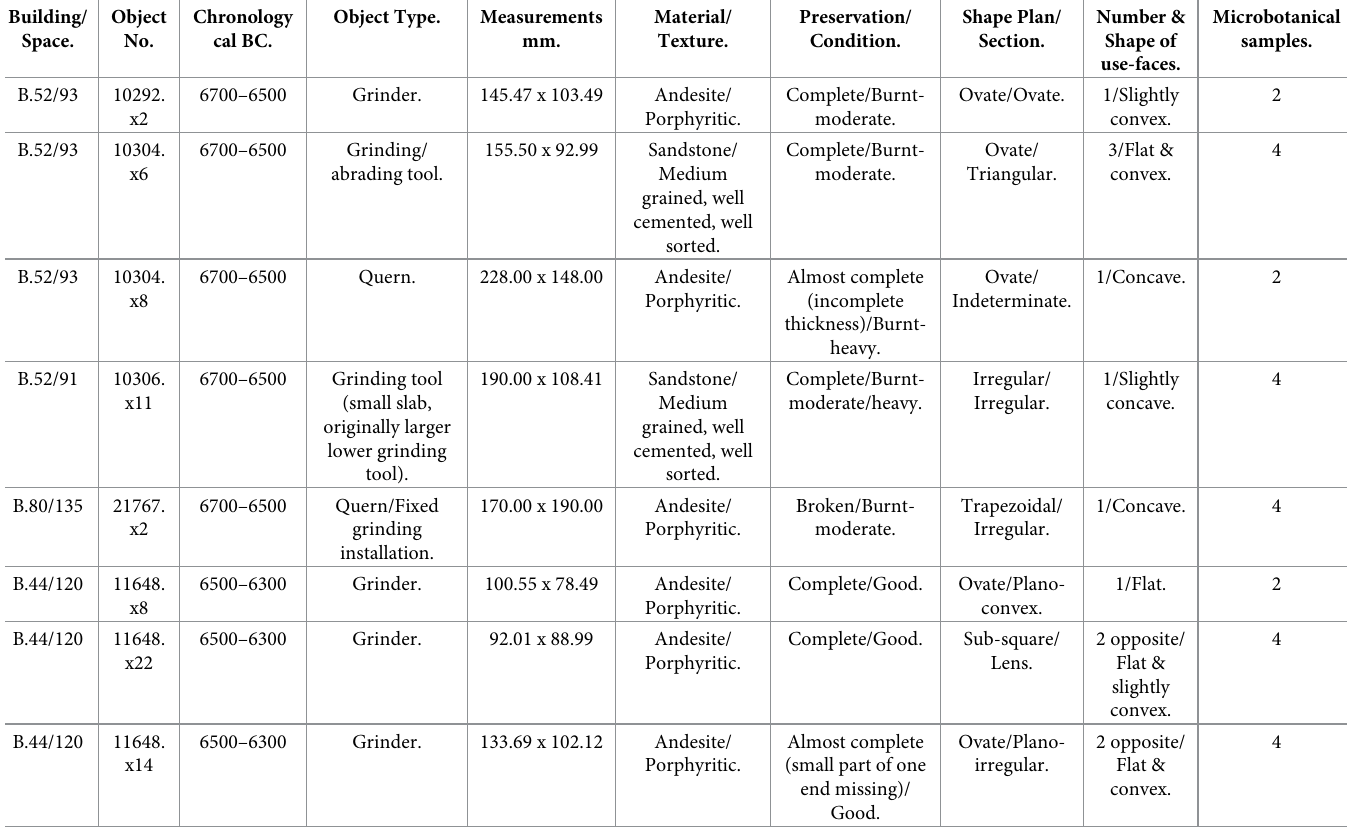
Description of grinding tools sampled for microbotanical and microwear